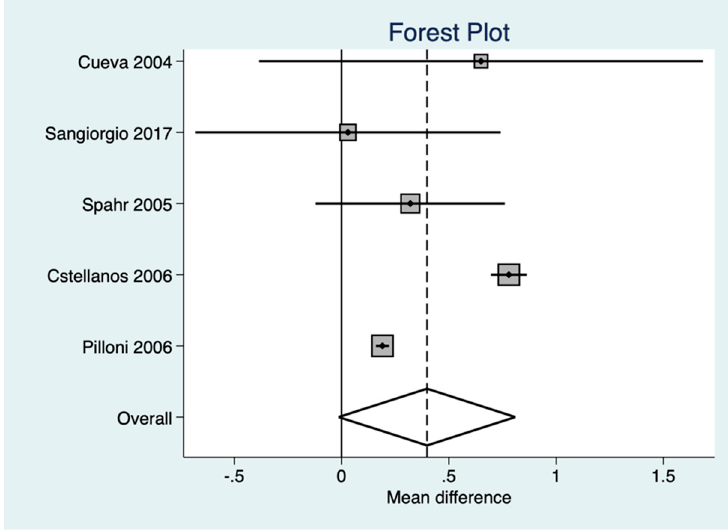
Table 6. Mean Difference and Confidence Interval (95%) are expressed in mm.